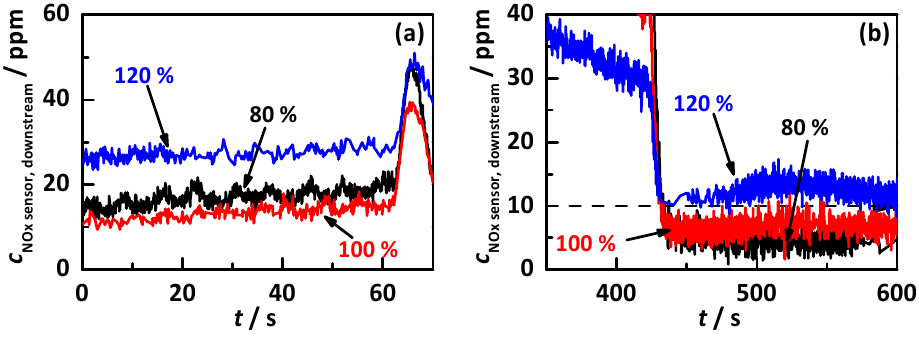
Figure 8. Detail view of the downstream NO x sensor signals at two characteristic points of the performed test cycles with percentage gradation of the ideal storage curve for 80% (black), 100% (red) and 120% (blue), with ( a ) the first change of operation point and ( b ) the change from full into medium load at maximum catalyst temperature.